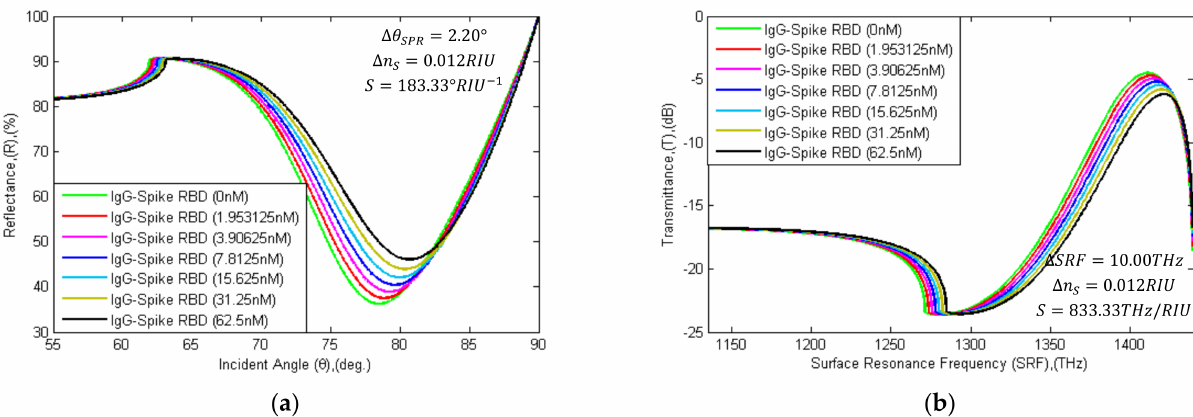
Figure 10. Schematic diagram of: ( a ) SPR and ( b ) SPRF characteristics of Bk 7 /Au(50 nm)/PtSe 2 (2 nm)/Graphene(1.7 nm) substrates with immobilized IgG (H014 or S309) as ligand and different concentration levels of SARS-CoV-2 spike RBDs (concentration of 1.953125 nM to 62.5 nM) as the